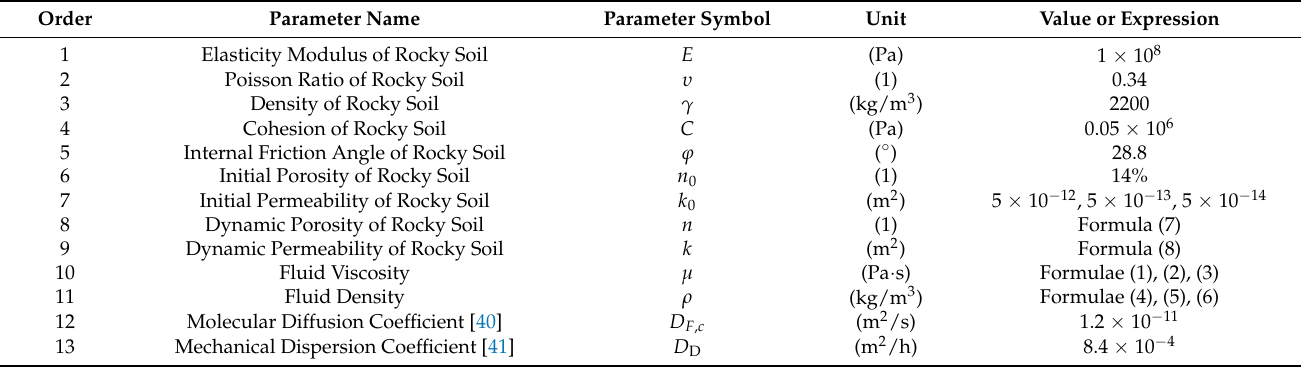
Refer to the “Thematic Design Report on Xianglushan” for the parameter values in Table 2. Parameter list of the numerical model. the numerical model. The exact values are shown in Table 2. Table 2. Parameter list of the numerical Table 2. Parameter list of the numerical model.